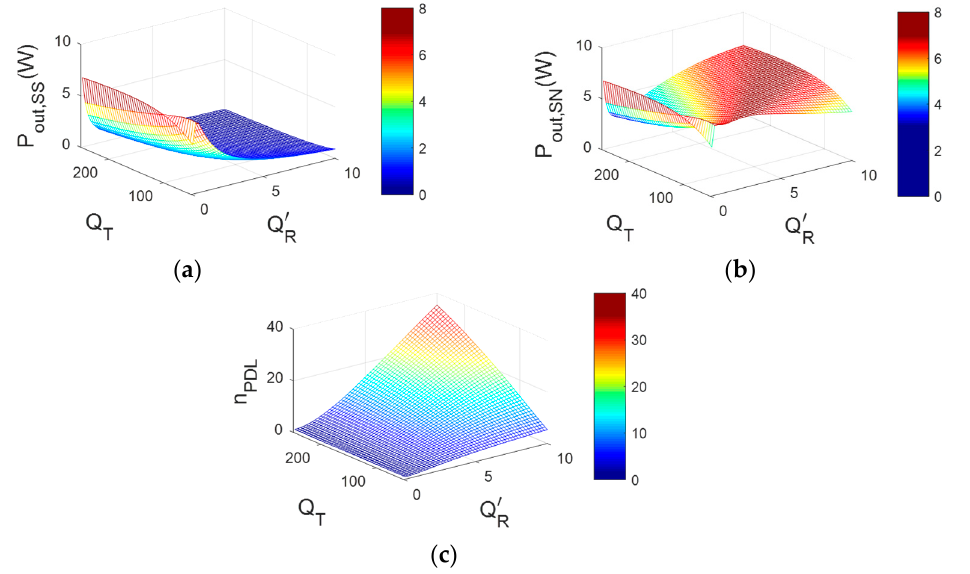
Figure 4. Calculated PDLs of ( a ) SS mode, P out,SS , ( b ) SN mode, P out,SN and ( c ) PDL ratio of SS and SN modes, n PDL , as a function of function of Q T and Q (cid:48)